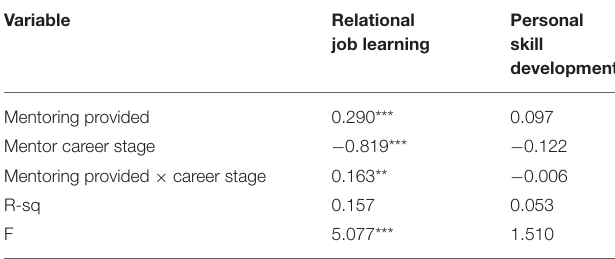
TABLE 6 | Moderation effect of the career stage of mentors.